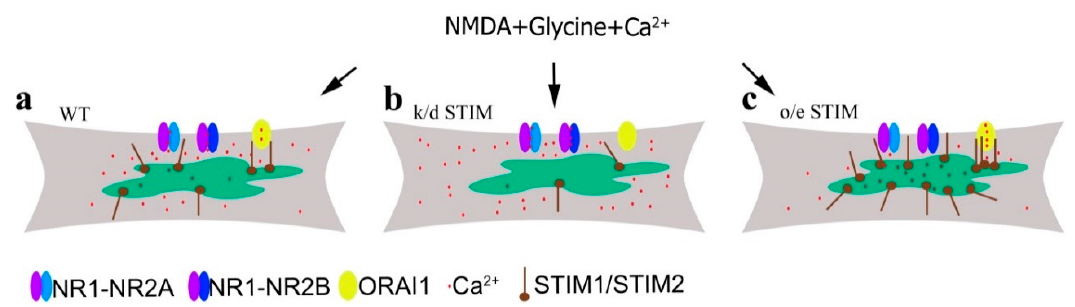
Figure 8. Proposed mechanism of changes in intracellular Ca 2 + level induced by NMDA in the presence of glycine (without Mg 2 + ) under the influence of di ff erent STIM protein expression. ( a ) In wild-type neurons with normal STIM protein expression, Ca 2 + influx occurs via NMDAR and Orai channels. ( b ) After STIM knockdown (k / d), Ca 2 + influx through the Orai channel is blocked and [Ca 2 + ] i is increased due to Ca 2 + influx via NMDAR and Ca 2 + retention in the cytosol and its failure to enter the ER. ( c ) Overexpressing STIM (o / e) inhibits NMDA-induced Ca 2 + influx into the cytosol and increases Ca 2 + storage in the ER.